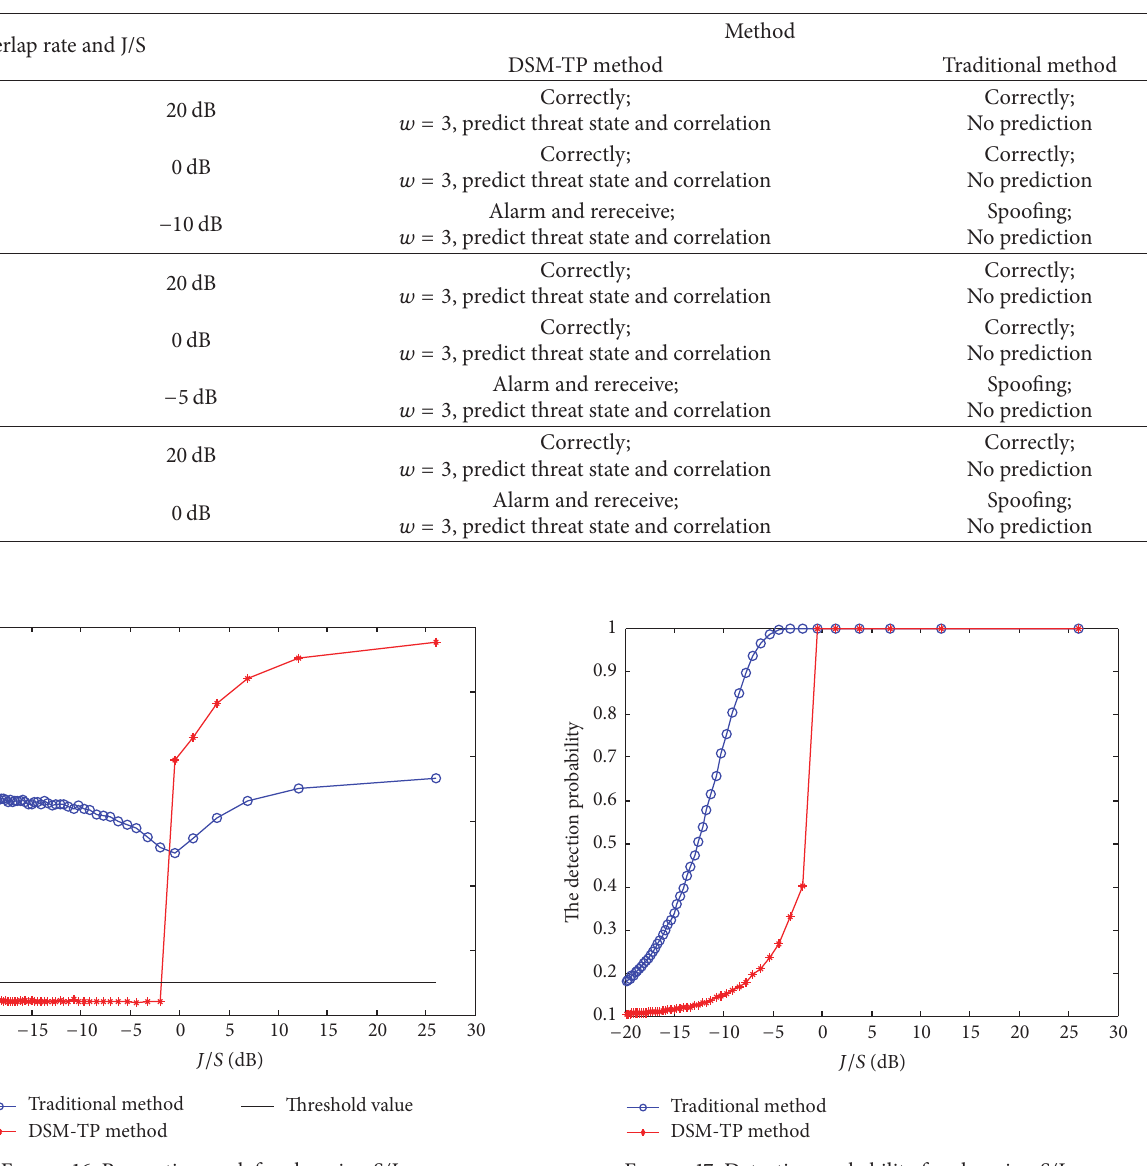
Table 3: Threat prediction results of the two methods.